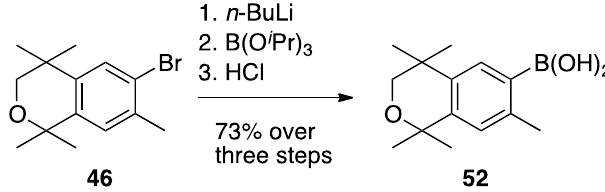
Figure 4 . X-ray crystal structure of a 0.114 × 0.141 × 0.380 mm 3 crystal of 26 . Thermal ellipsoids are shown at 50% probability